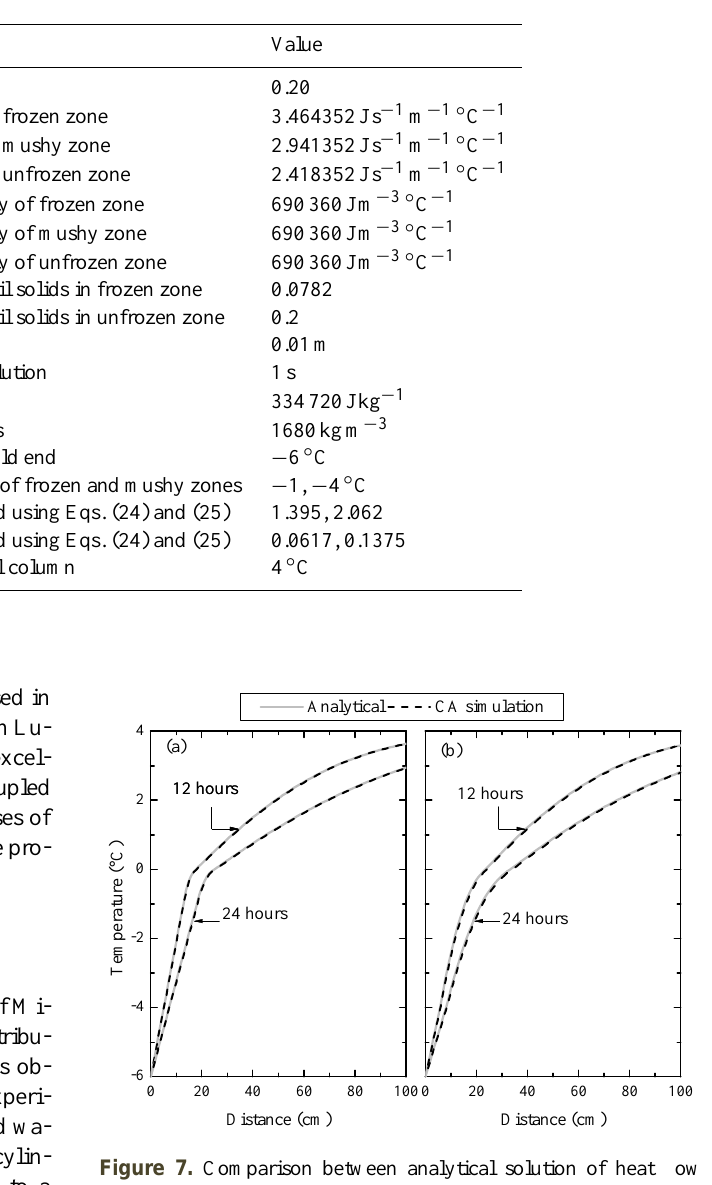
urated hydraulic conductivity of 3 . 2 × 10 − 6 m s − 1 and van Genuchten parameters α = 1 . 11 m − 1 and n = 1 . 48. The hy- draulic conductivity of the cells with ice was reduced using an impedance factor of 2. The thermal conductivity